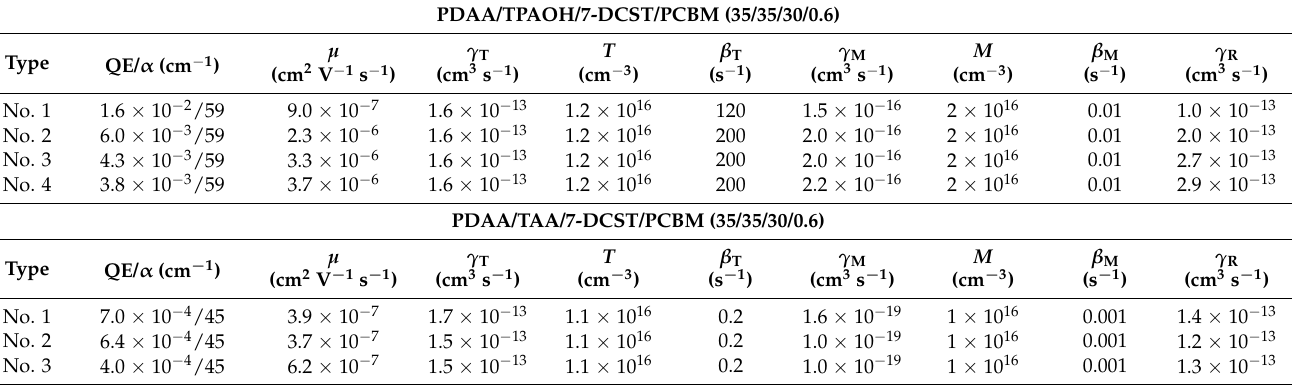
Table A1. Summary of the simulation